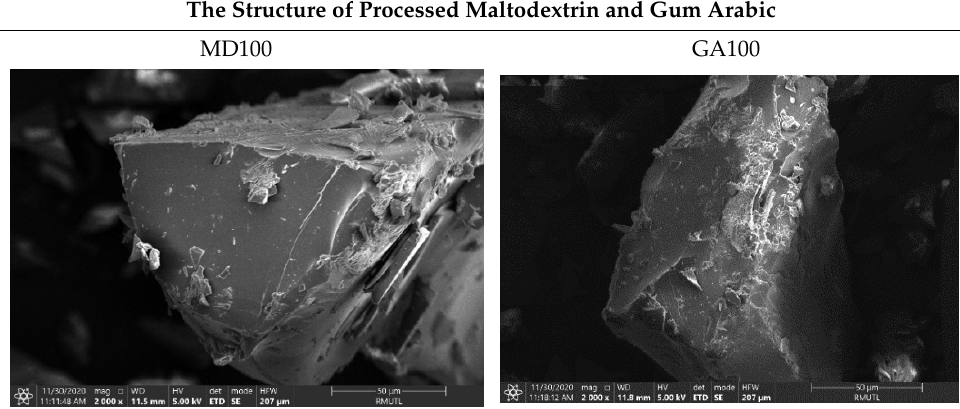
Table 5. Characteristics of the wall materials.